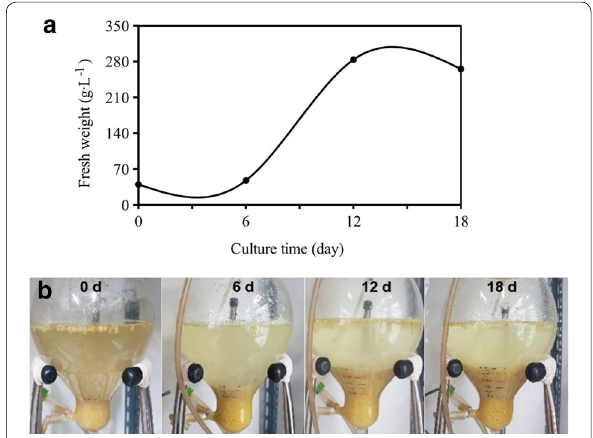
Fig. 4 Cell growth of transgenic carrot callus in air‑lift bioreactor during culture period. a Packaged cell growth in bioreactor; b Fresh weight per liter medium